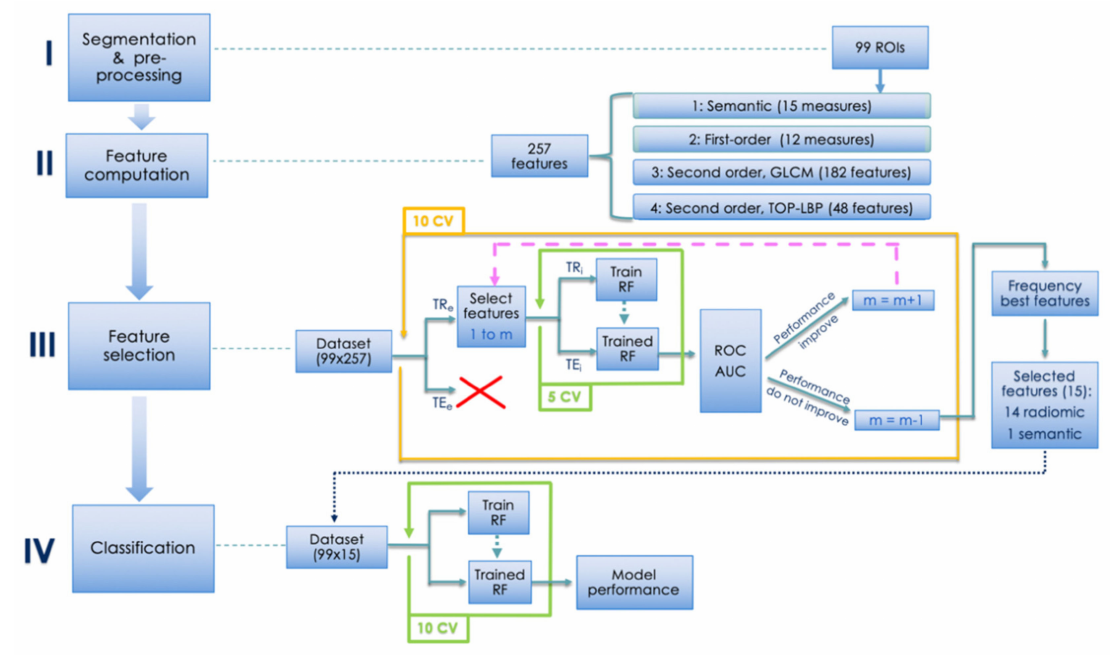
Figure 1. Schematic representation of the proposed approach. TR and TE denote the training and the test set, whilst the subscript e and i stand for external and internal cross-validation, respectively.